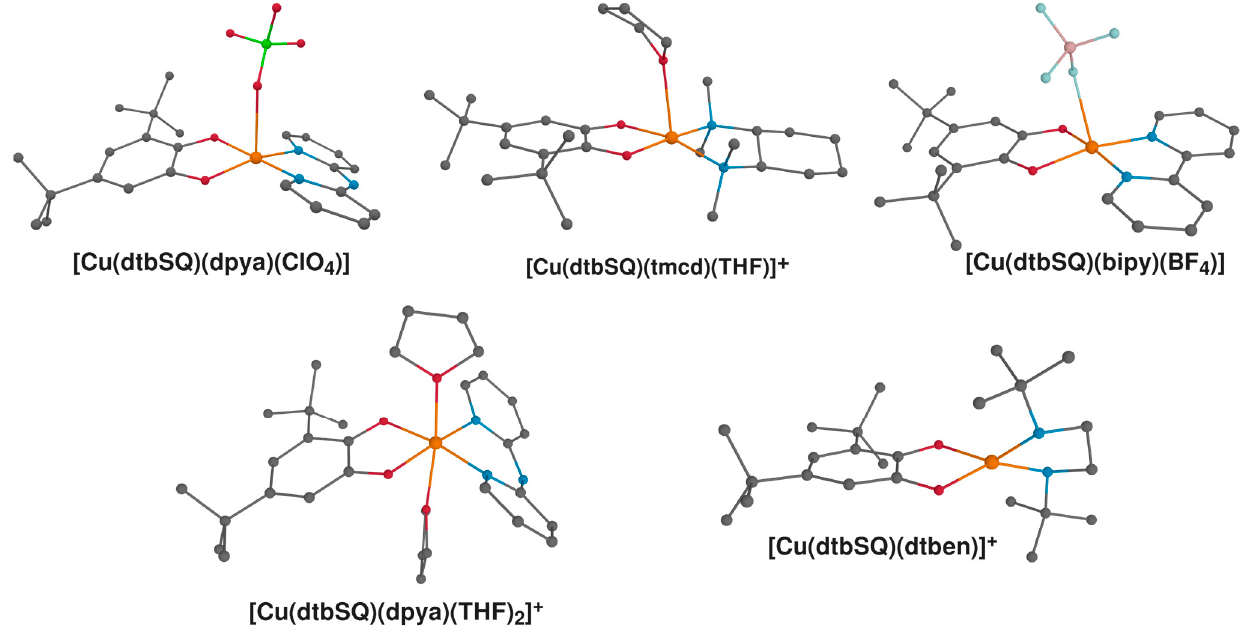
Figure 8. Structures of semiquinonato Cu(II) complexes characterized experimentally that were in-